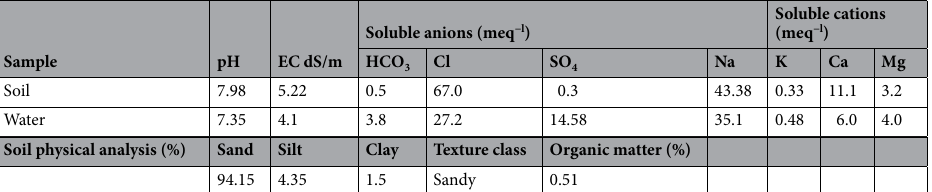
Table 1. Chemical and physical characteristics of soil sample at the